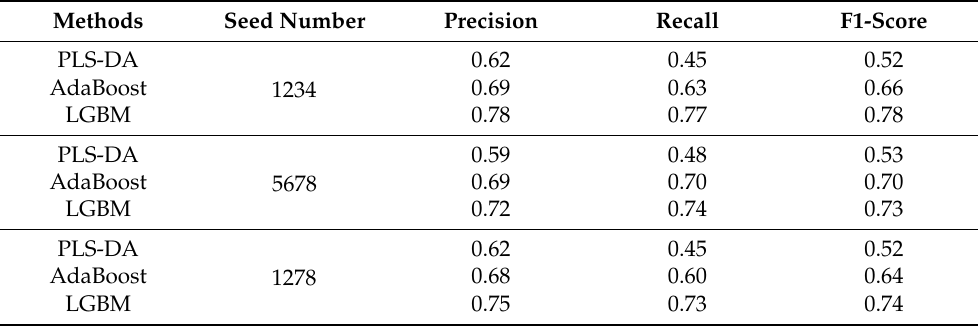
Table 4. The precision, recall, and F1-score values of the established models for HOB properties.